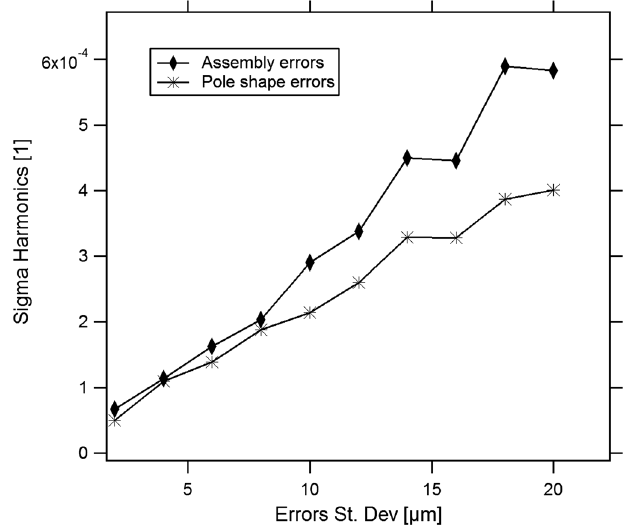
FIG. 7. PM sensitivity to magnetic errors. Errors are in percent and angle errors are in degrees. Initial position: PM blocks without vertical translation; translated: PM blocks with 5 mm translation. Six blocks with independent magnetic errors are installed in each slot.